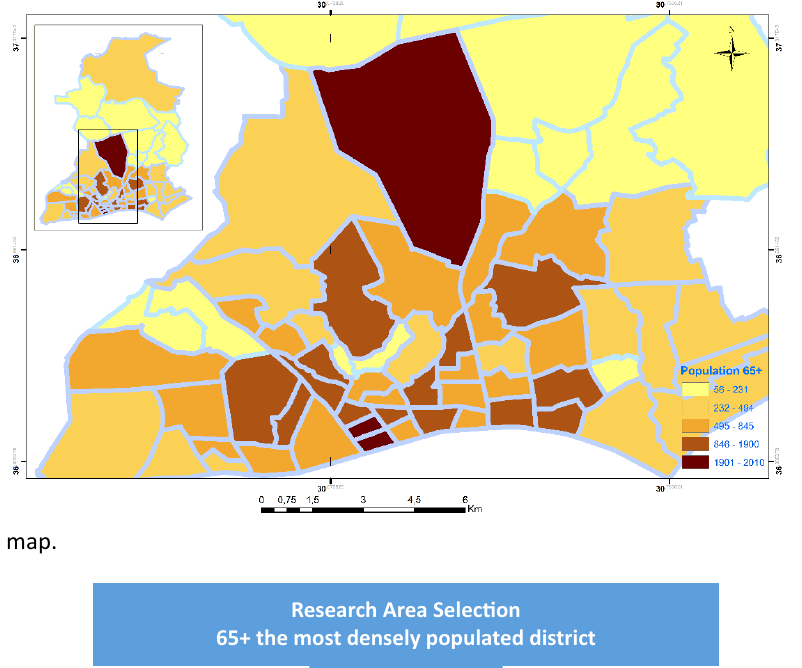
Figure 3. Age density map.